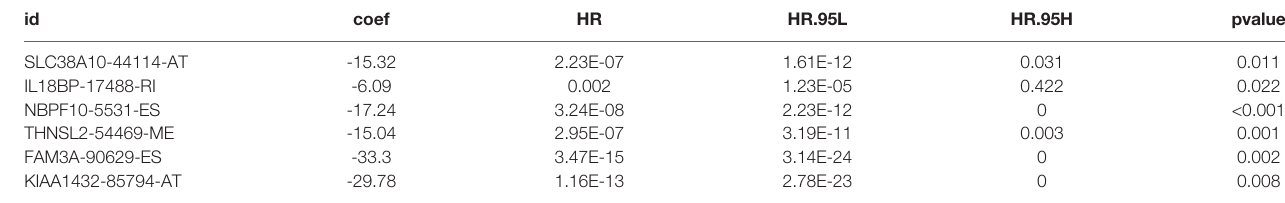
TABLE 2 | Multivariate cox